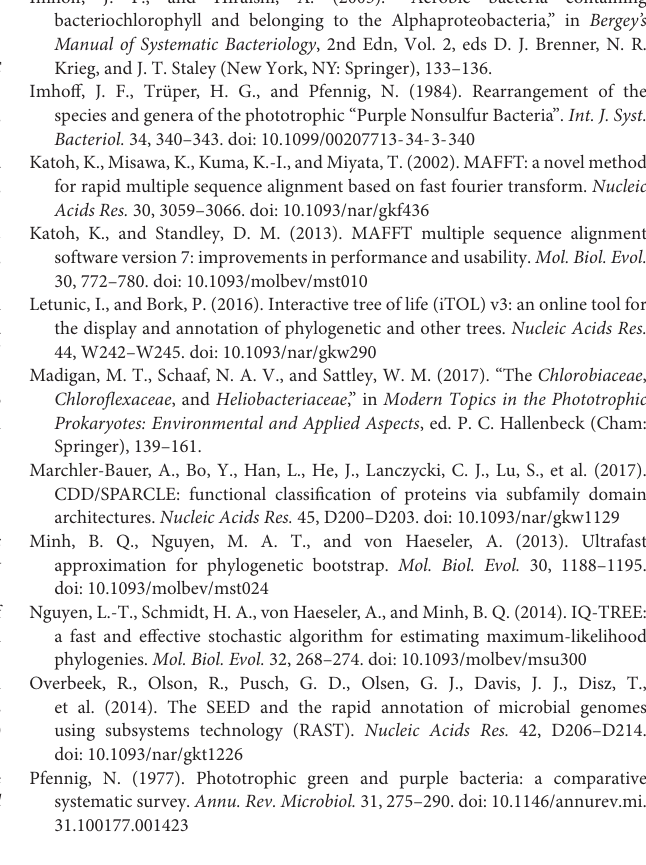
TABLE S1 | Sequences and deposition numbers of PufLM together with systematic information of the strains studied. DATA SHEET S1 | Alignment of PufLM sequences analyzed in this